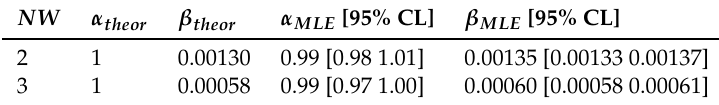
Table A1. Gamma distribution parameters ( α , β ) for theoretical and maximum-likelihood